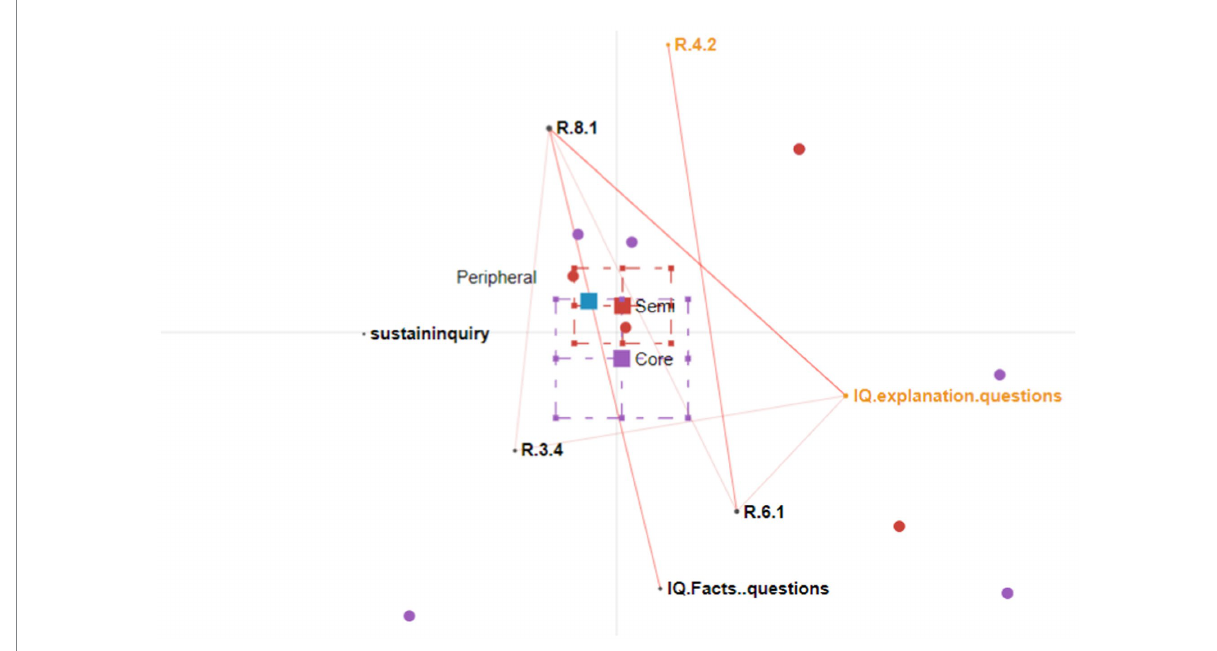
FIGURE 4 Epistemic network analysis participation graph for regular group. Core = leader; semi = regular.